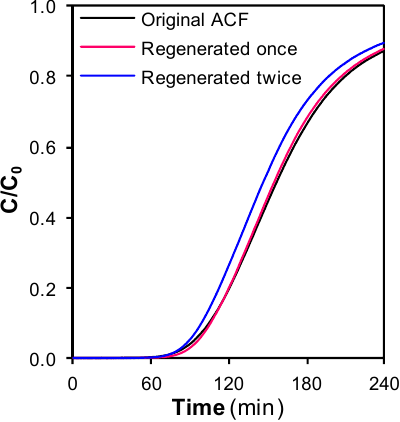
Figure 2. Phenol breakthrough curves for the original activated carbon fiber (ACF) and the sample regenerated with SCCO 2 at 250 °C after the first and the second adsorption–regeneration cycle.